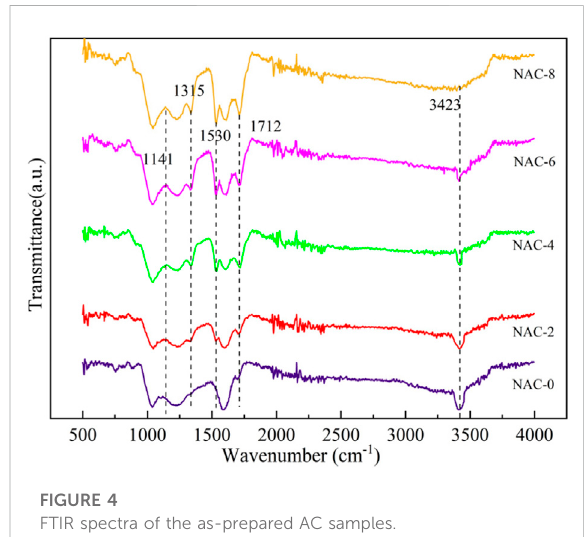
FIGURE 4 FTIR spectra of the as-prepared AC